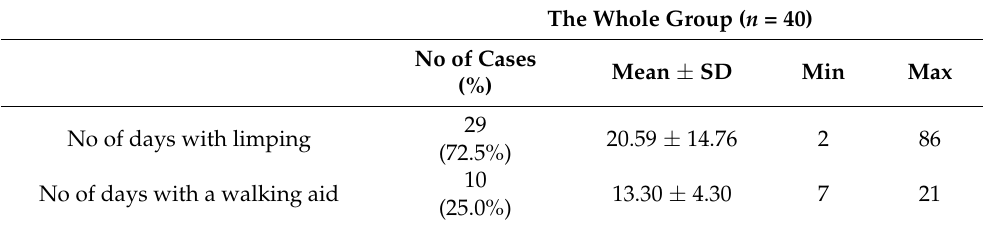
Table 4. Descriptive statistics characterizing difficulties in ambulation after the procedure of cancel- lous bone harvesting from the proximal tibia in the general group of patients. The Whole Group ( n = 40) (%)